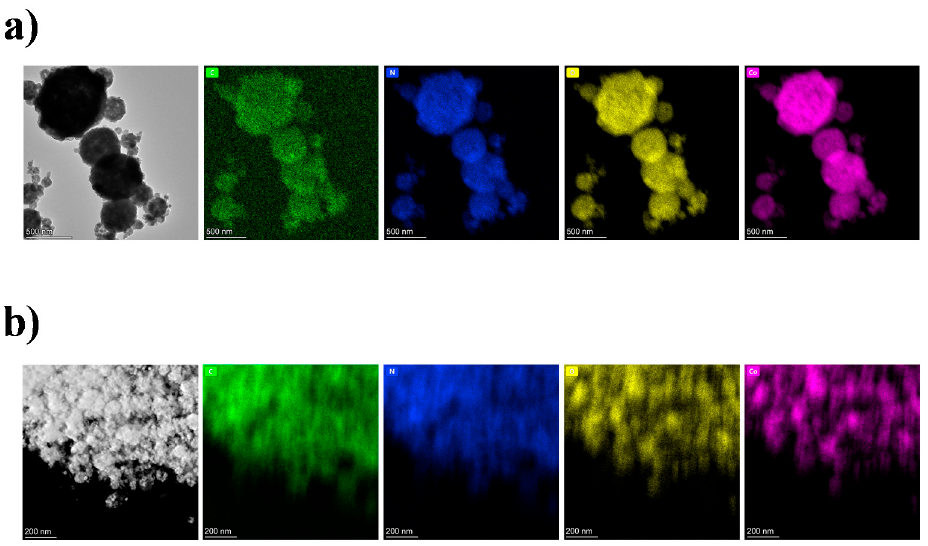
Figure 3. TEM elemental mapping of carbon, nitrogen, oxygen and cobalt in ( a ) HPC-Co (1) and ( b ) HPC-CoO (2).